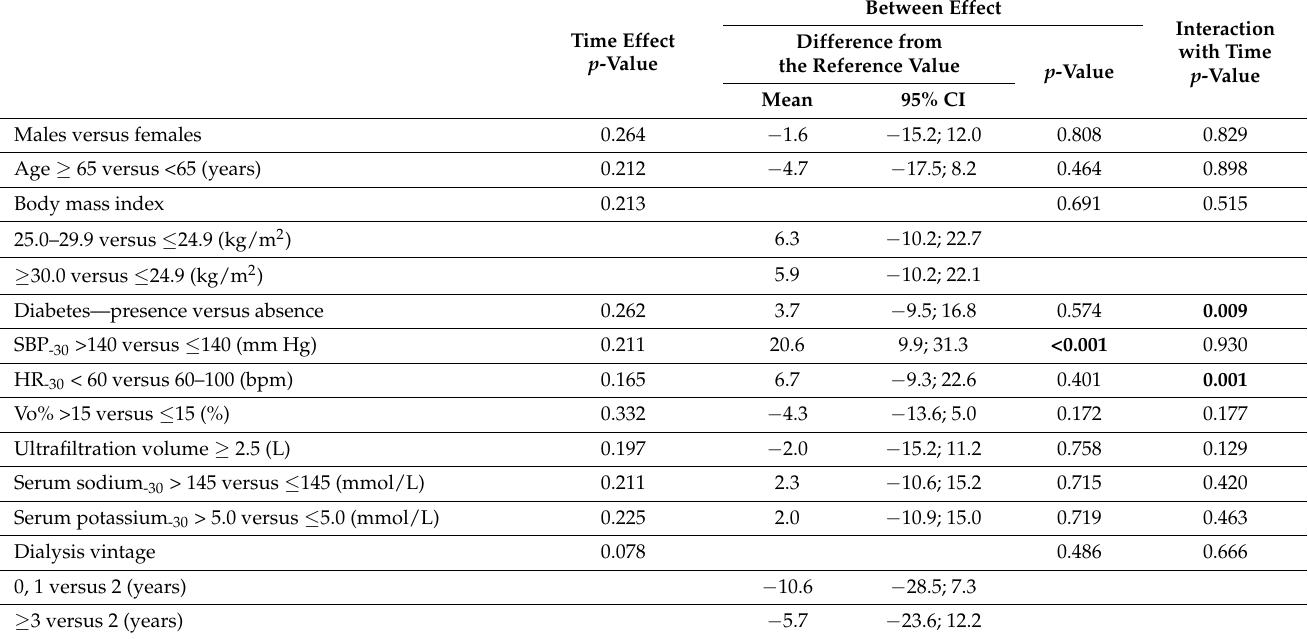
Table 3. Dynamics of systolic blood pressure during hemodialysis in relation to selected clinical and dialysis